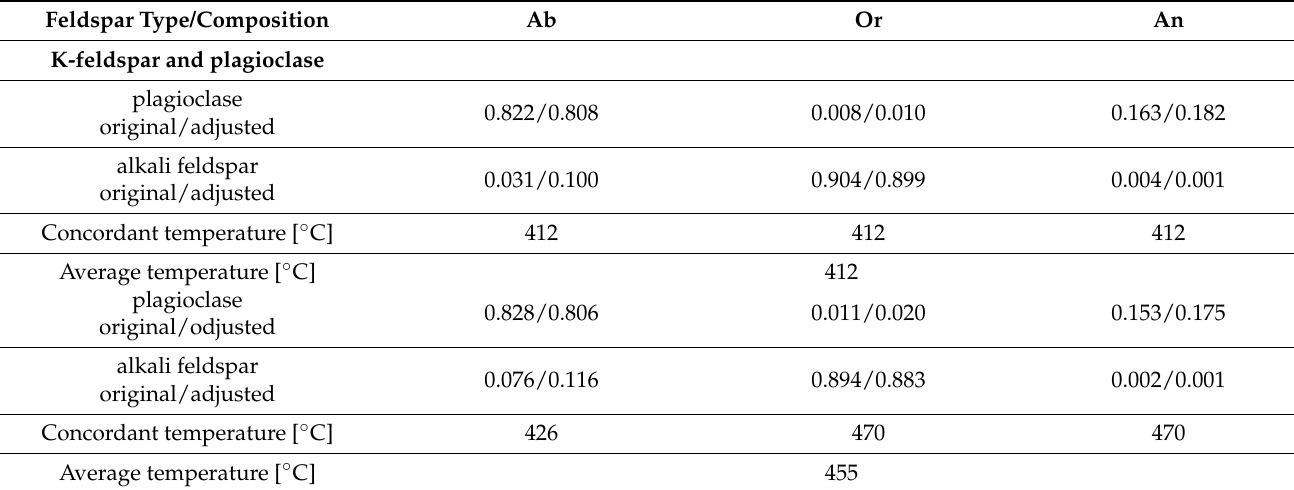
Table 3. Modal composition and temperature estimate obtained using the Fuhrman and Lindsley [33] ternary feldspars geothermometry for feldspars from the exotic block from Pluskawka microgranite (Pl 2).